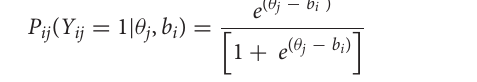
Scores on the Studied